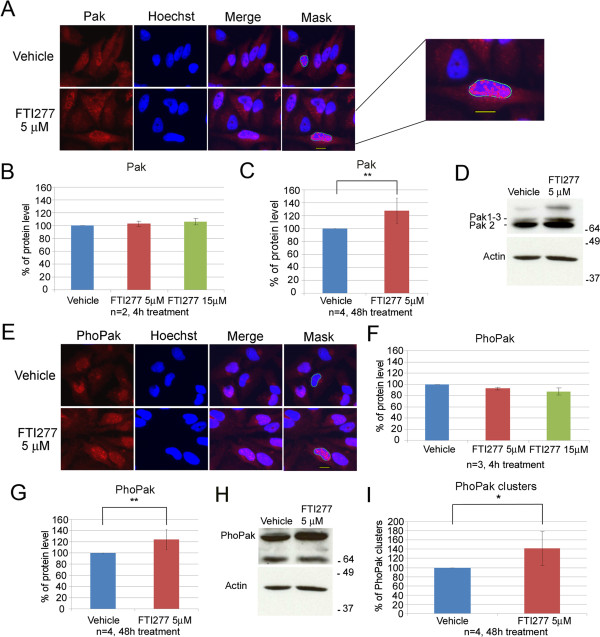
FTI-277 treatment of HeLa cells up-regulates PAKs and phosphorylated PAKs. The statistical significance of the treatments was calculated using t-test: ns = not significant, p-value >0.05; * = significant, p-value <0.05; ** highly significant = p-value <0.01). n = n. of biological replicates. Each biological replicate consider the average mean intensity data obtained from analysis of three wells per condition. A. Fluorescently stained HeLa cells treated for 48 h with the indicated concentration of FTI-277 or DMSO (Vehicle). Panels: PAK = anti-PAK (C19) antibody; Hoechst = nuclear staining; Merge = Hoechst + PAK; Mask: software mask that identifies nuclear PAKs (green), and PAK clusters (spots) within nuclei (red). scale bar =10 μm. B. The graph shows the relative amount (%) of PAKs in the nuclei in 4 h FTI277-treated cells relative to vehicle, arbitrarily set as 100%. C. The graph shows the relative amount (%) of total PAKs in 48 h FTI-277-treated cells compared to vehicle-treated cells; D. Immunoblot analysis of total lysates from HeLa cells treated as indicated in C. E. Fluorescently stained HeLa cells treated for 48 h with the indicated concentration of FTI-277 or DMSO (vehicle). Panels: PhoPak = α-Phospho-PAK1/2/3[pThr423] antibody; Hoechst = nuclear staining; Merge = Hoechst + PhoPak; Mask: software mask that identifies nuclear PhoPaks (green), and PhoPak clusters (spots) within nuclei (red). F. The graph shows the relative amount (%) of total PhoPaks in 4 h FTI277-treated cells relative to vehicle-treated cells. G. The graph shows the relative amount of total PhoPaks in 48 h FTI277-treated cells compared to vehicle-treated cells; H: immunoblot analysis of total lysates form HeLa cells treated as in G. I. The graph shows the relative number (%) of PhoPaks spots within the nuclei in 48 h FTI277-treated cells relative to vehicle-treated cells, which were arbitrarily considered 100%.